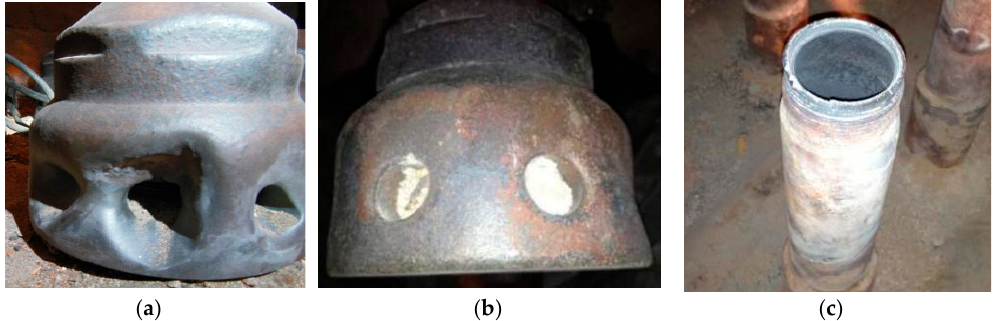
Figure 3. Three kinds of nozzle A used in the engineering project: ( a ) cover of nozzle A1; ( b ) cover of nozzle A2; ( c ) inner tube of nozzle A3.